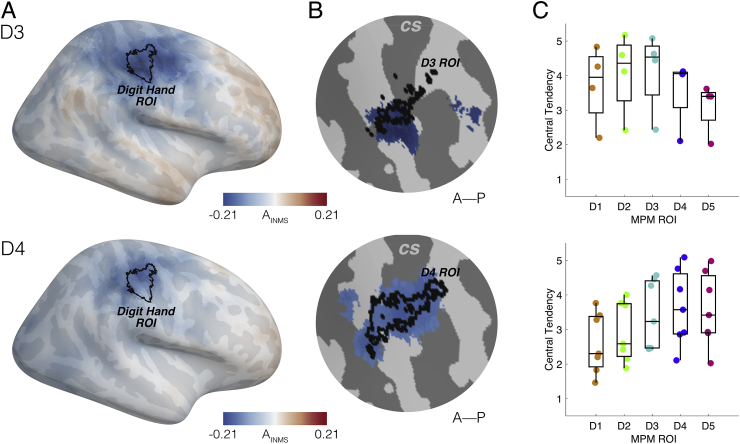
The application of the atlas to verify findings from a somatosensory study using MEG. A) Group-averaged functional activation images from experiments stimulating left D3 (top row) and left D4 (bottom row) showing the reduction of beta (13–30 ​Hz) oscillations during stimulation. The digit hand ROI is shown in black for reference. B) Zoomed in representations of the central sulcus, with an arbitrary threshold of 80% applied to the functional images and the corresponding digit ROIs from the MPM atlas in black. Note that the threshold is for illustrative purposes. C) The quantification of the central tendency scores within each of the atlas MPM ROIs for each experiment (unthreshold images). The experiment-median central tendency is correctly identified to be highest within the ROI corresponding to the digit stimulated in both subsets of experiments, implying the maximal reduction of beta power is specific to the digit simulated.